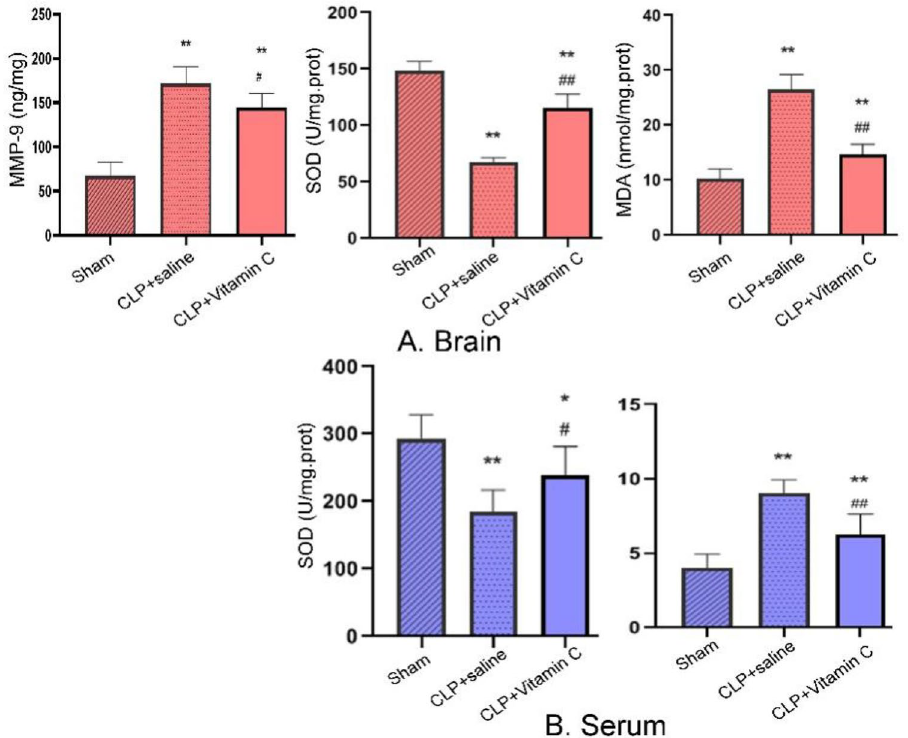
Figure 4. Comparison of the MMP-9 (24 h after operation), SOD and MDA levels in brain hippocampus and serum in three groups. MMP-9 in the hippocampus was significantly (P = 0.000) increased in the hippocampus in both the CLP + saline and the CLP + vitamin C groups, but significantly (P = 0.02) reduced with treatment of vitamin C compared with the CLP + saline group. Compared with the sham group, the activities of SOD in the serum and hippocampus were significantly (P = 0.000 and P = 0.03, respectively) diminished while the levels of MDA in the serum and hippocampus were significantly (P = 0.007) increased in both the CLP + saline group and the CLP + vitamin C group. Compared with the CLP + saline group, the levels of SOD were significantly (P = 0.03 and P = 0.000, respectively) increased while the levels of MDA were significantly (P = 0.002